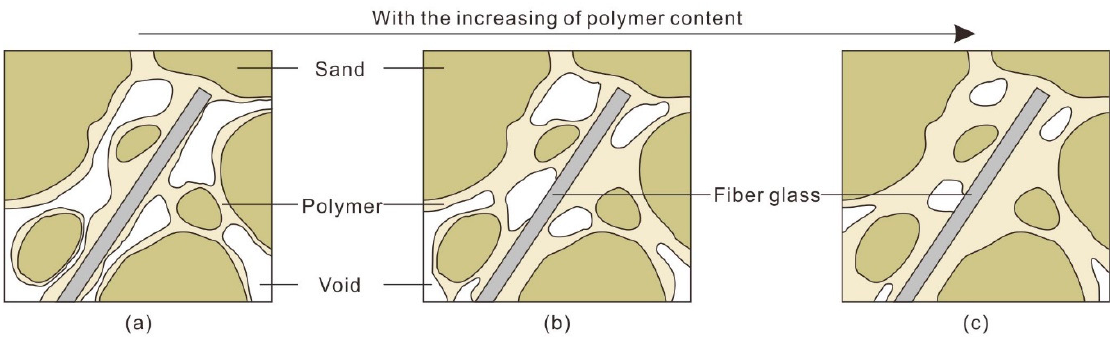
Figure 15. Schematic drawing of the microstructure of reinforced sand at different polymer contents. ( a ) Low polymer content; ( b ) Medium polymer content; ( c ) High polymer content.